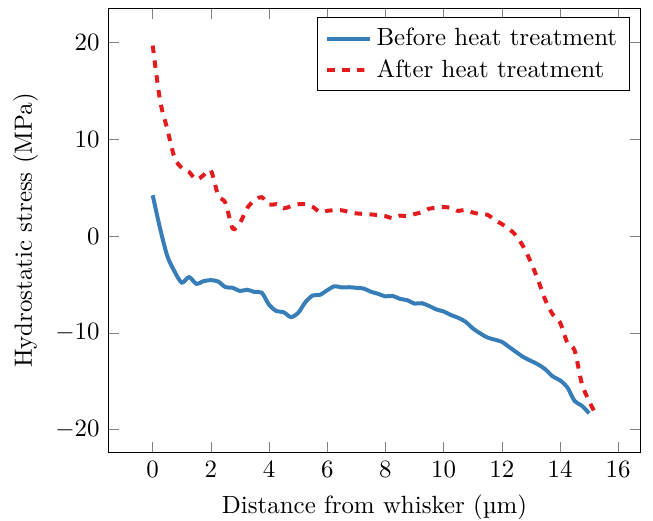
Figure 13. Hydrostatic stress as a function of distance from the whisker. Distance 0 is taken in the centre of the whisker grain, at level with the sample